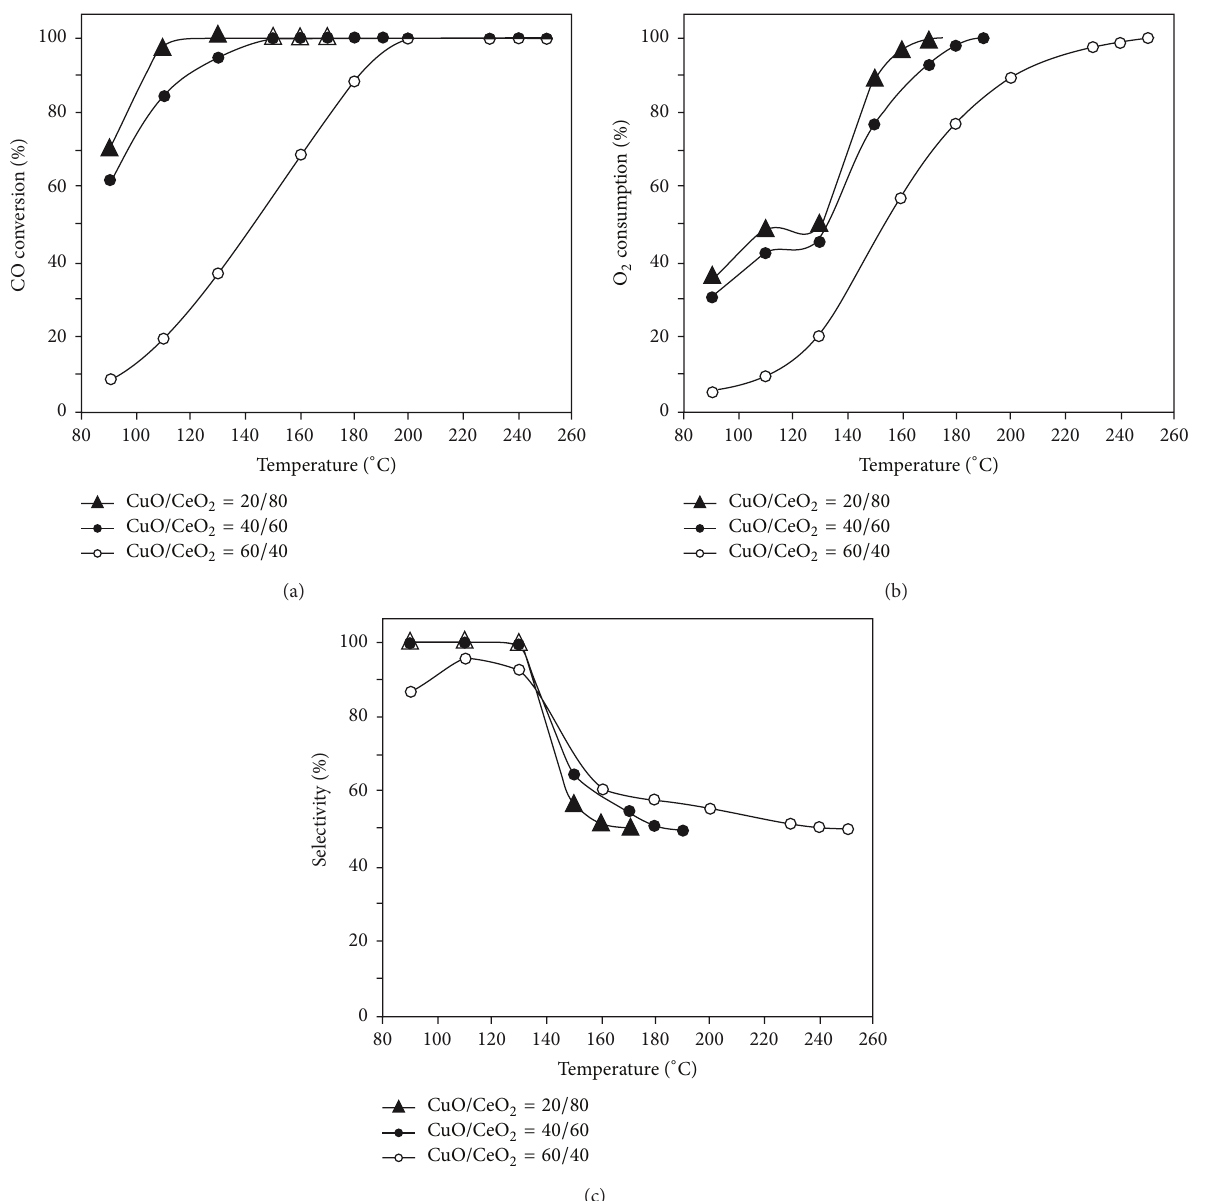
Figure 5: Selective CO oxidation performances of CuO/CeO 2 catalysts of various weight ratios: (a) CO conversion, (b) O 2 consumption, and (c) selectivity to CO. Feed composition (v/v): 1% CO, 1% O 2 , 60% H 2 , and balance with He. SV = 60,000 cm −3 g −1 h −1